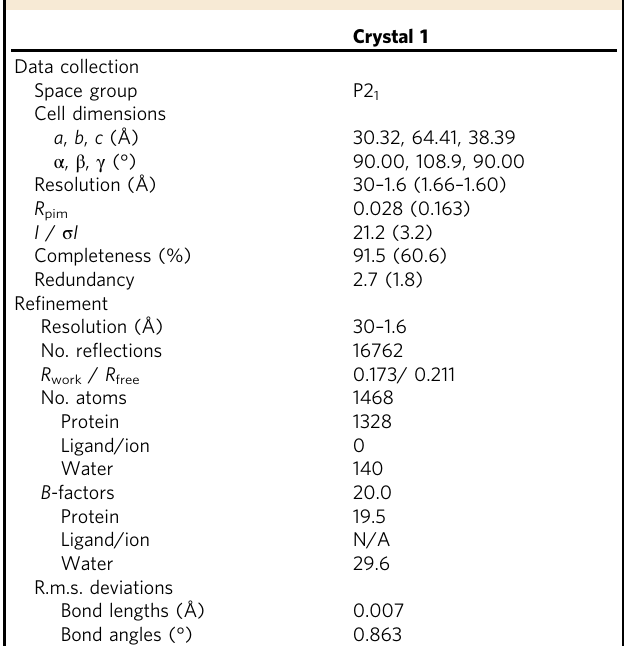
Table 1 Data collection and re fi nement statistics (molecular